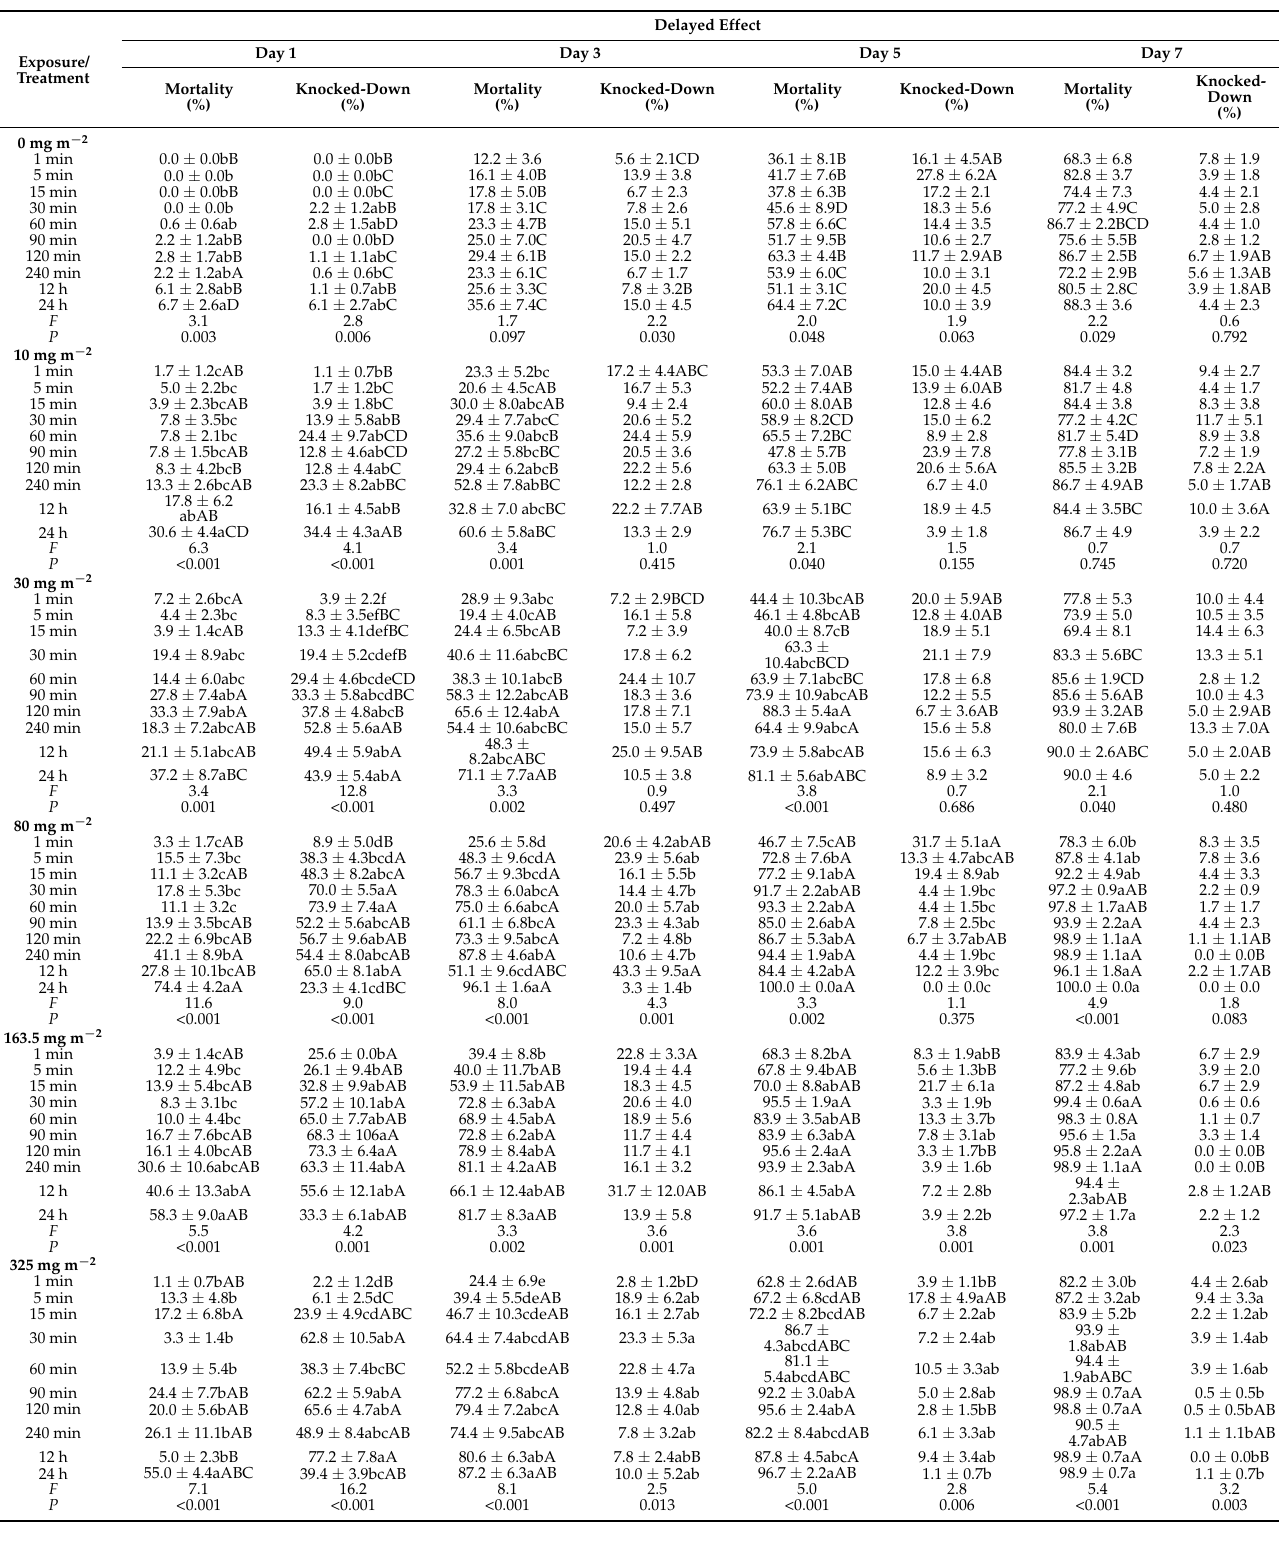
Table 3. Mean mortality and knock-down effect ± SE of Ephestia elutella adults exposed for 1, 5, 15, 30, 60, 90, 120, and 240 min and 12 and 24 h to nets with different concentrations of alpha-cypermethrin (0, 10, 30, 80, 163.5, and 325mg m − 2 ) after 1, 3, 5, and 7 d of exposure (delayed